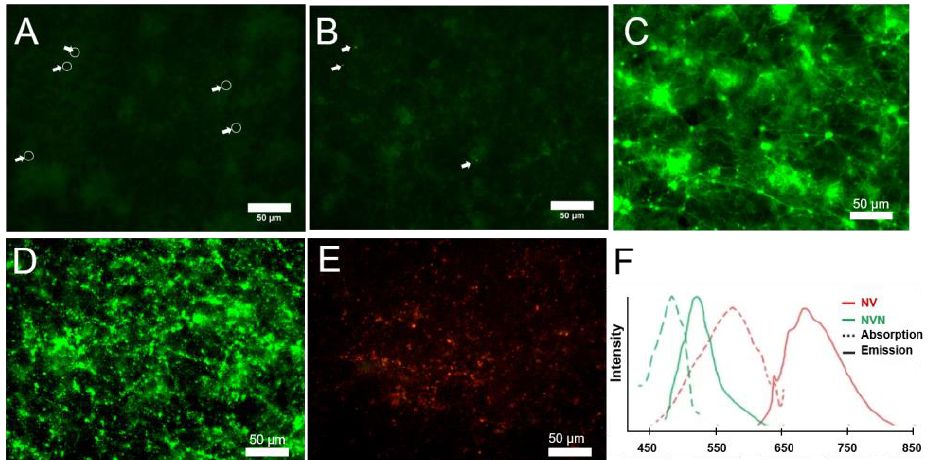
Figure 2. Views of a clot under various conditions. ( A ) Clot alone, with erythrocytes circled and arrowed; ( B ) clot + FND (green) alone (no biotinylated fibrinogen), with individual particles high- lighted with arrows; ( C ) clot + fibrinogen FITC; ( D ) clot + biotinylated fibrinogen + avidin-FND (green); ( E ) clot + biotinylated fibrinogen + avidin-FND (red); and ( F ) excitation and emission spectra for NV and NVN containing FND. Scale bars 50 um. Green Ex/Em: 470/488LP. Red Ex/Em: 517/561LP.